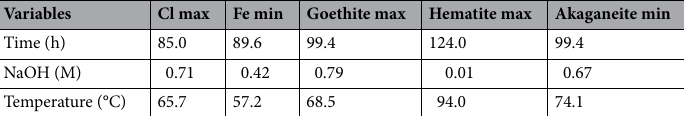
Table 6. Optimal variables conditions obtained by using the surface